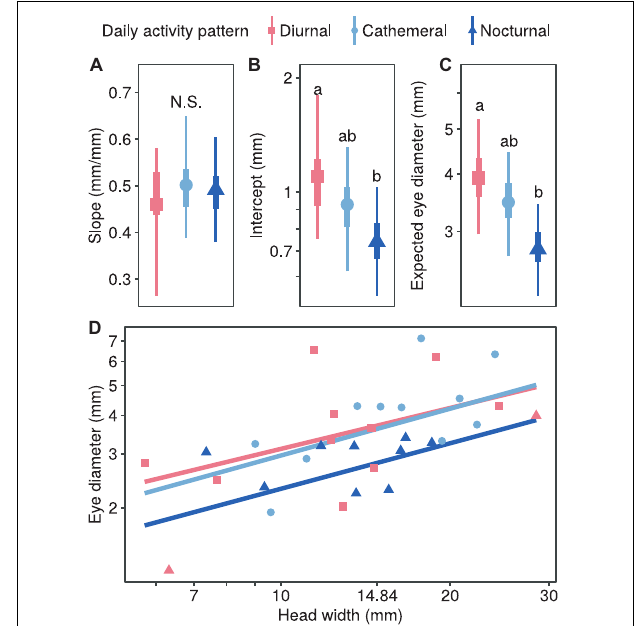
Posterior medians and 95% highest density intervals are listed.